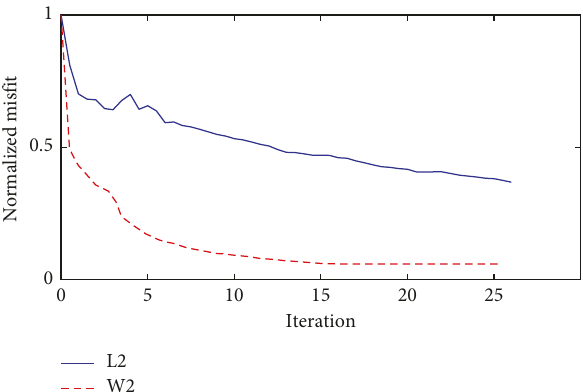
Figure 5: Reduction of waveform residuals with increasing number of iterations.